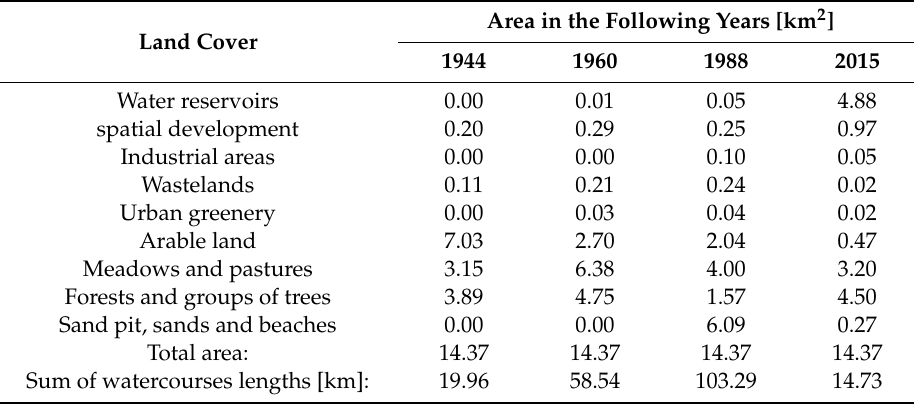
Table 1. Changes in land use in the area of Ku´znica War˛e˙zy´nska in the period 1944–2015. Area in the Following Years [km 2 Land Cover